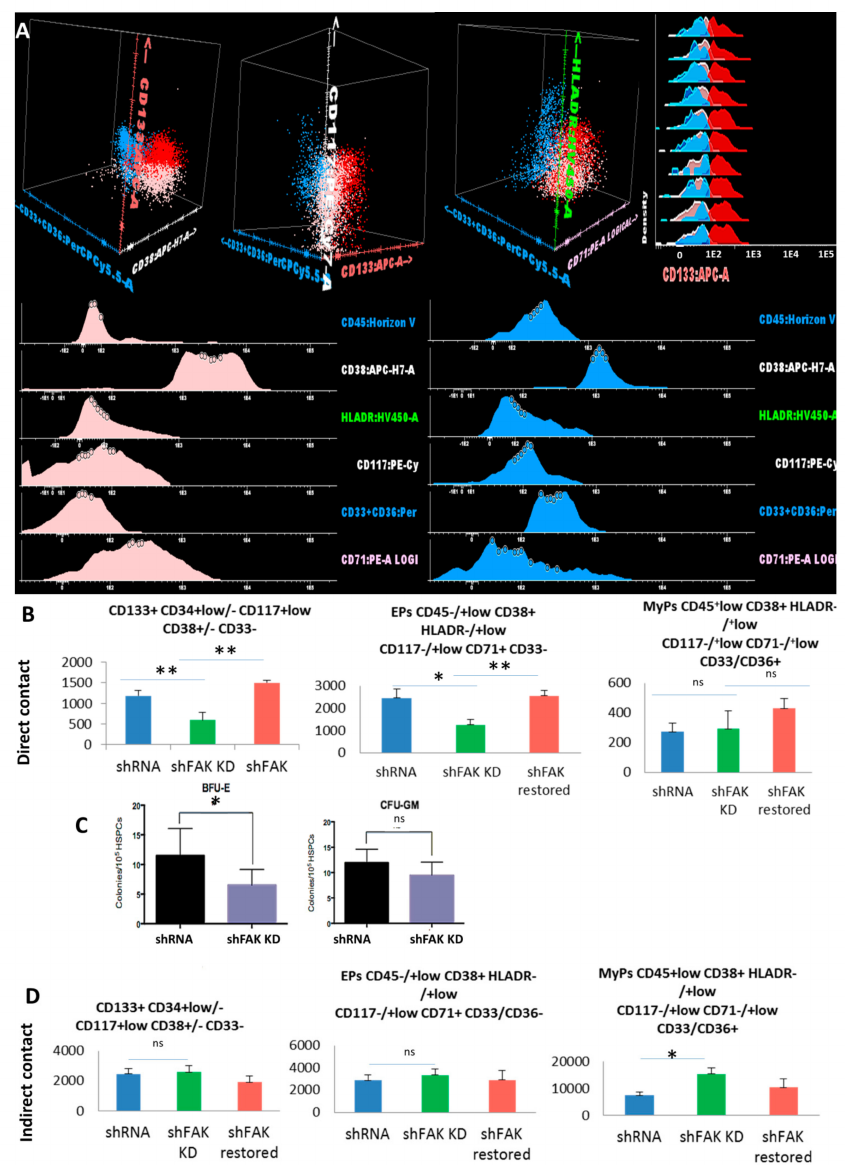
Figure 6. Reduced immature haematopoietic stem cells’ recovery and impairment of erythroid differentiation are observed after co-culture between CD34 + HD-HSCs with FAK shRNA HS-5 cells compared to control shRNA cells. ( A ) Three populations can be identified inside the CSFE + HSPC population recovered after two weeks of co-culture with FAK shRNA HS-5 or control shRNA: Immature HSCs CD45 + low CD133 + HLADR- /+ low CD117 + low CD71 + low CD33 / CD36- cells (red dots), erythroid precursors’EPsCD45- /+ lowCD133-HLADR- /+ lowCD117- /+ lowCD38 + CD33 / 36-CD71 + low(palepink dots), and other myeloid precursors’ MyPs CD45 + low CD38 + HLADR + low CD117- /+ low CD33 / CD36 + CD71- (blue dots). ( B ) Absolute cell count evaluation of the immature CD133 + HSCs, Eps, and MyPs after two weeks of direct contact with FAK shRNA HS-5 cells compared to control shRNA and FAK shRNA cells after WT FAK re-expression (n shFAK KD = 5, n shRNA = 5, n shFAK restored = 3). ( C ) Burst-forming unit-erythroid evaluation of non-adherent HSPCs recovered from long-term direct co-culture with FAK shRNAHS-5 cells compared to control shRNA. ( D ) Evaluation of the proliferation capacity and erythroid differentiation ability of HSPCs recovered from indirect long-term co-culture between CD34 + HD-HSCs and FAK shRNA HS-5 cells compared to control shRNA and FAK shRNA cells after WT FAK re-expression (n shRNA Control = 5, n shFAK KD = 5, n shFAK restored = 3). p < 0.05(*); p <